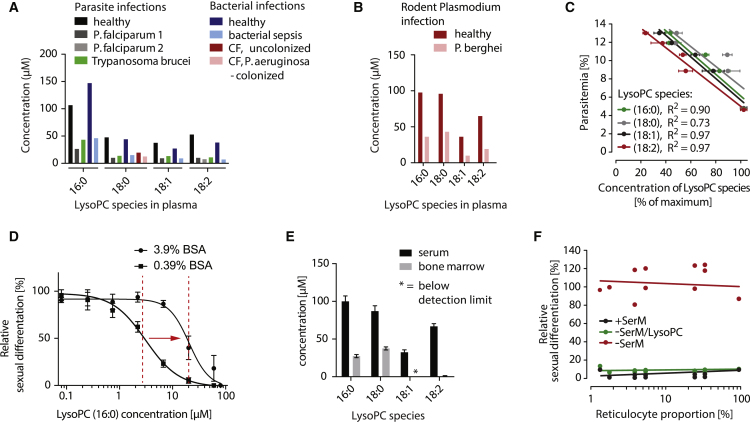
Physiological LysoPC Levels Are Conducive to Sexual Commitment(A) LysoPC levels drop during bacterial and parasitic infection in humans. The effect of different infections on serum LysoPC concentration is shown (Drobnik et al., 2003, Lakshmanan et al., 2012, Lamour et al., 2015, Ollero et al., 2011, Orikiiriza et al., 2017). CF, cystic fibrosis.(B) LysoPC levels drop during rodent malaria infection. LysoPC species were quantified in mice infected with P. berghei (parasitemia of 10%–14%) and in healthy control mice.(C) LysoPC levels in P. berghei-infected mice correlate negatively with parasite burden. Shown is the correlation between LysoPC concentration (different species are indicated) and parasitemia in peripheral blood of five mice. Correlation coefficients are indicated. Concentrations of LysoPC species are normalized to maximum concentration found across all mice (see Figure S5 for absolute quantities). Standard errors of the mean are shown.(D) Elevated BSA levels increase the IC50 of LysoPC for sexual commitment. Higher LysoPC concentrations are required to prevent parasite sexual commitment in presence of 3.9% BSA compared to 0.39% BSA. n = 3. Standard errors are shown.(E) LysoPC levels are lower in bone marrow compared to serum. Shown are LysoPC levels in serum and cell-free bone marrow extracts from healthy mice. n = 5. Standard errors of the means are shown.(F) Sexual differentiation rates of Pf2004/164tdTom parasites cultured in erythrocytes of different maturity. Parasites were allowed to invade into reticulocyte-enriched erythrocyte populations, and sexual differentiation was monitored for inducing (−SerM) and for non-inducing (−SerM/LysoPC and +SerM) conditions. Each data point represents a biological replicate (mean of technical triplicates). Sexual differentiation rates were normalized to a reticulocyte-negative control population cultured under inducing −SerM conditions.See also Figure S5.